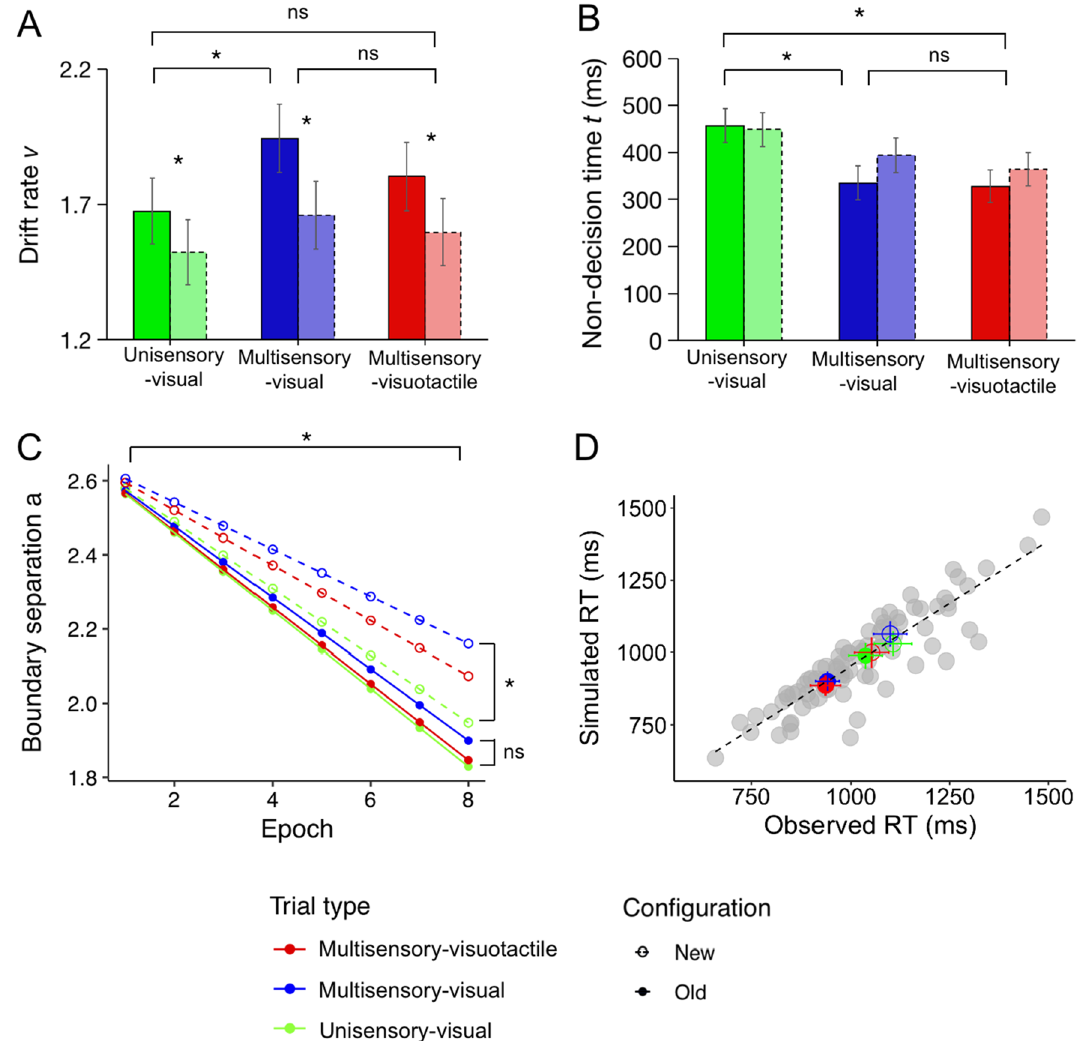
Figure 7. Mean drift rate v ( A ) and non-decision time t ( B ) estimated by hierarchical drift–diffusion modeling as a function of (unisensory-visual, multisensory-visual, multisensory-visuotactile) Trial type and (old, new) Configuration. Error bars depict the standard deviation. Light colored bars indicate new configurations and darker colored bars old configurations. Panel ( C ) shows the function relating boundary separation to epoch number, separately for the experimental (Trial type × Configuration) conditions. Asterisks (*) represent posterior probabilities ≥ 95%. Panel ( D ) depicts predicted (simulated) vs. observed RT data for each observer in all conditions, with model predictions generated from the preferred model. Each observer contributed six data points, one for each (Trial type × Configuration) condition, represented as gray dots. The mean RTs across all observers in each condition are represented by the colored dots. If model predictions match the observed data, the plotted symbols should fall along the diagonal